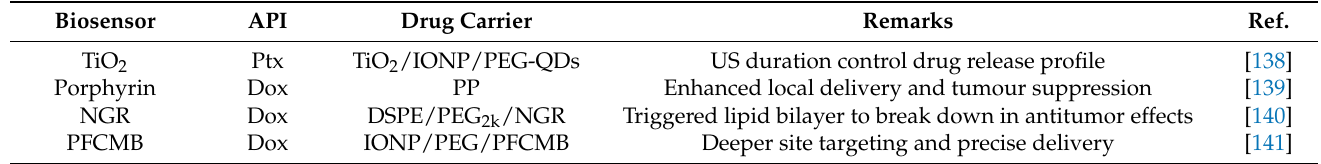
Table 6. Sonodynamical triggers with biosensors to release API in drug carriers, with remarks